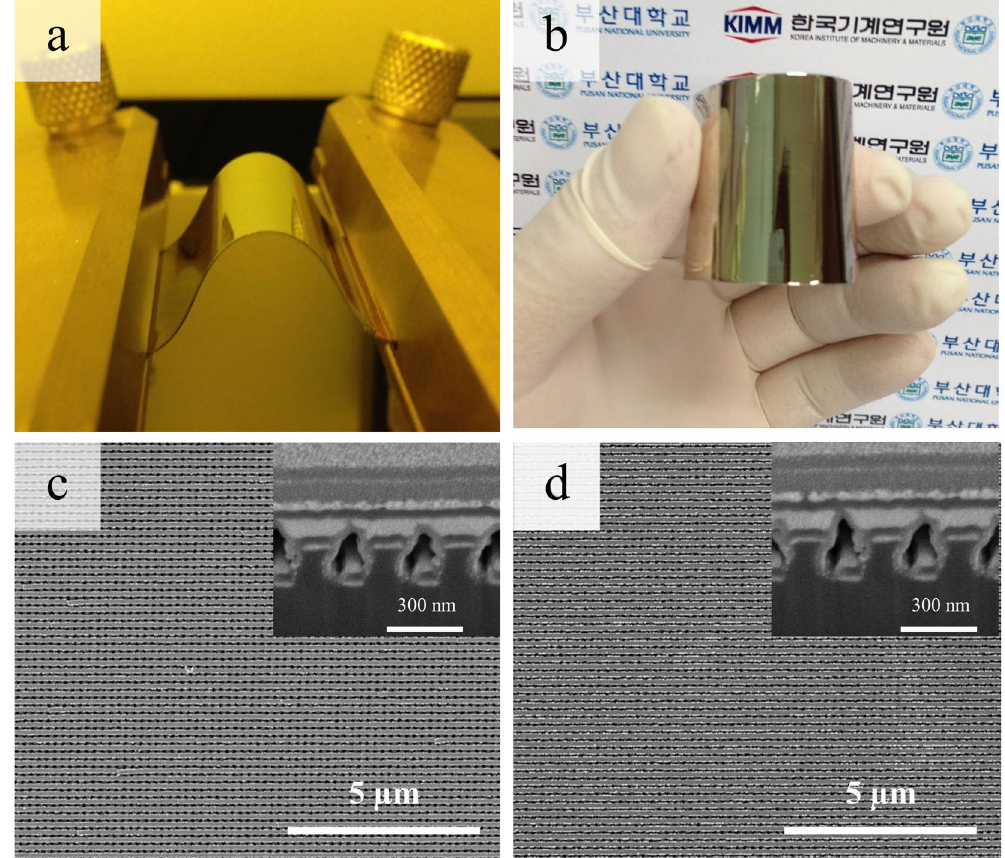
Figure 8. Photographs and SEM images of fabricated sample before and after bending test. ( a ) and ( b ) bending photographs; ( c ) and ( d ) SEM images of sample before and after bending test,